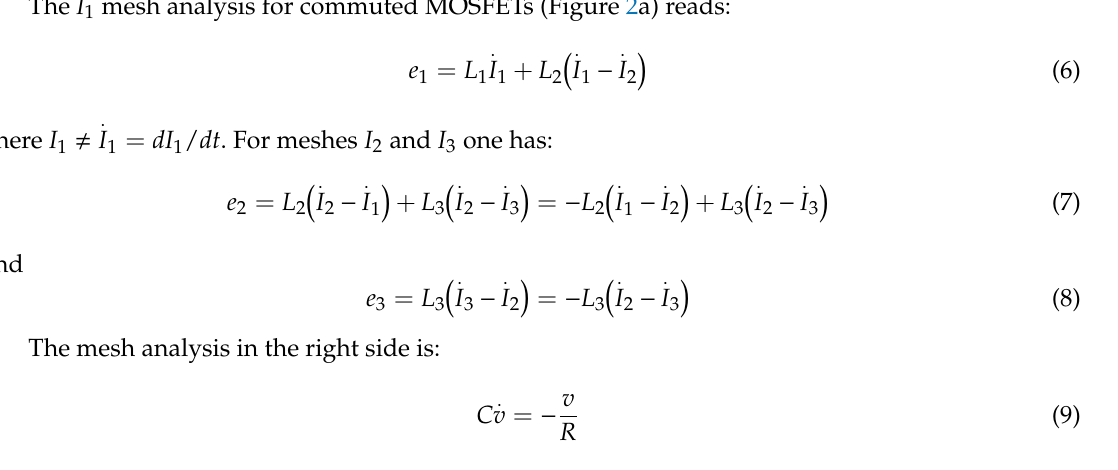
Figure 2. Switched configurations for the converter with: ( a ) commuted MOSFETs and ( b ) non- commuted MOSFETs, for 𝑛 = 3